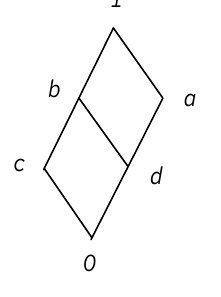
Fig. 2 Hasse diagram